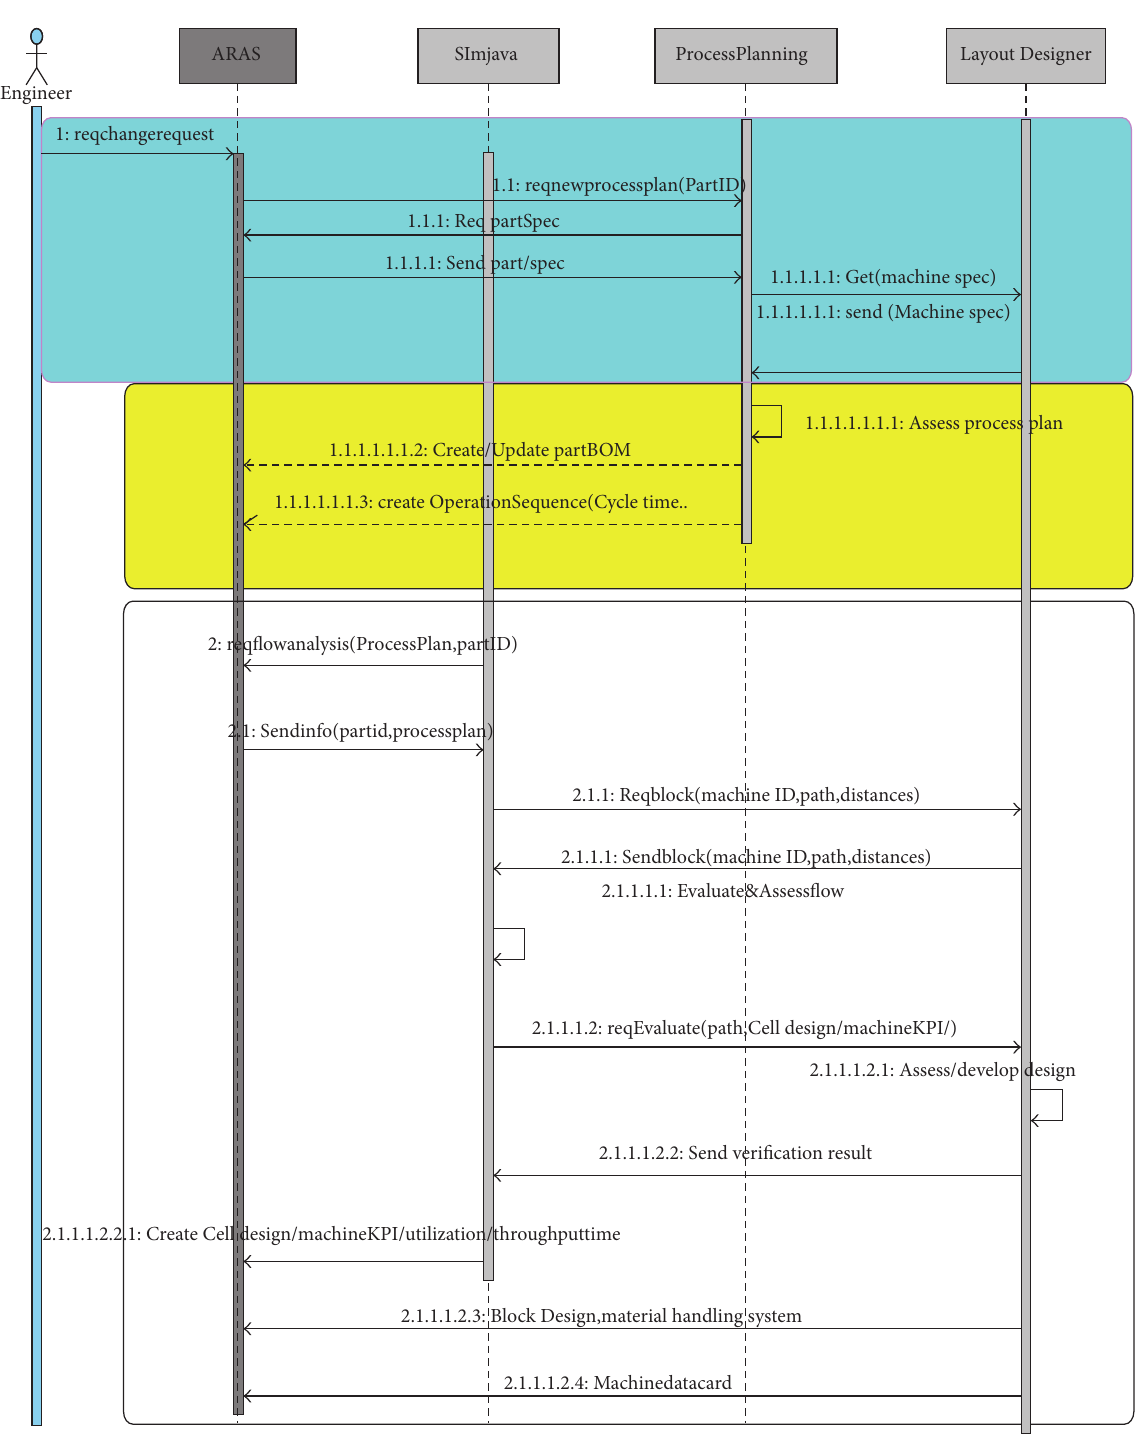
Figure 12: An UML sequence diagram to identify the interactions between domains in the case